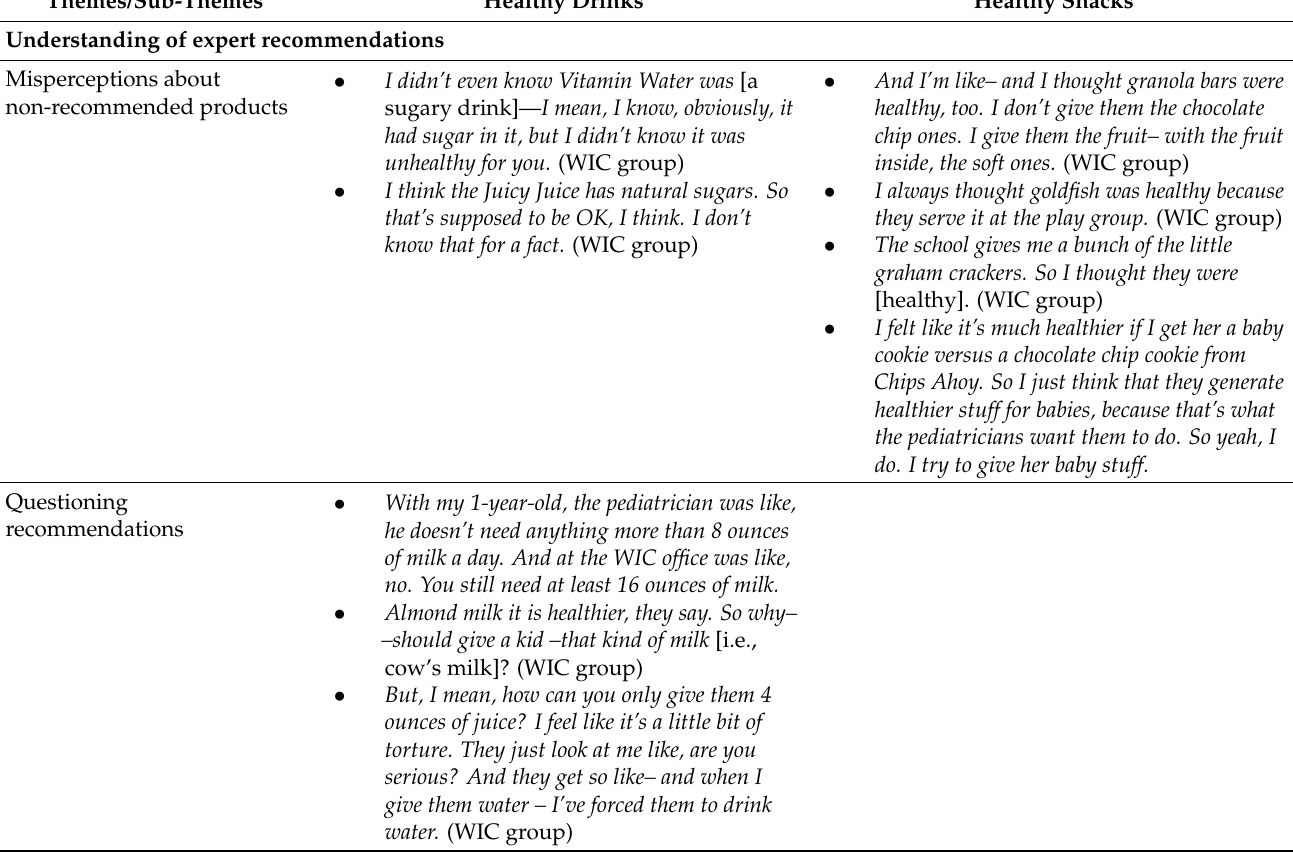
Table 2. Representative quotes for the main themes and sub-themes in the thematic analysis.